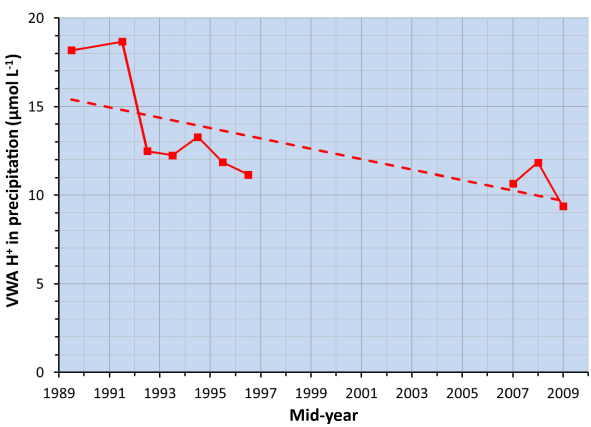
Figure 6. Temporal trend in annual VWA H + in precipitation asso- ciated with NEUS/SEUS